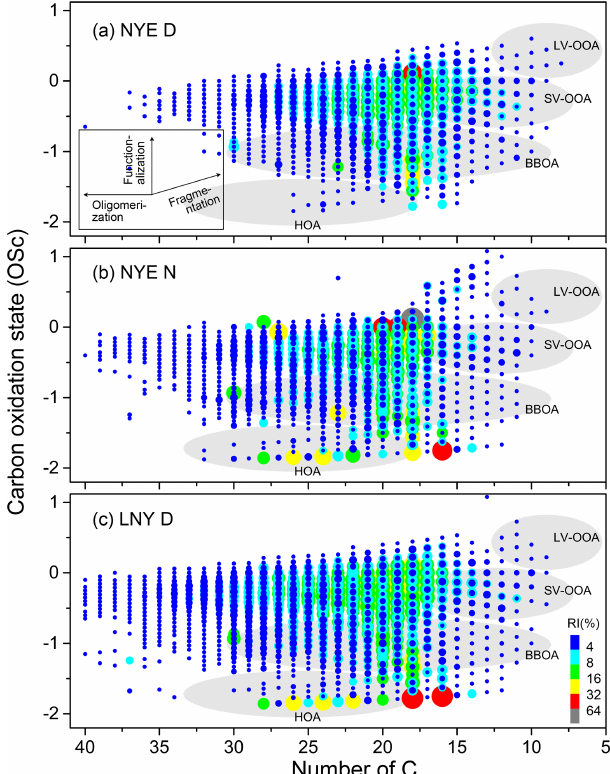
Table 3. The number of compounds with various AI values.